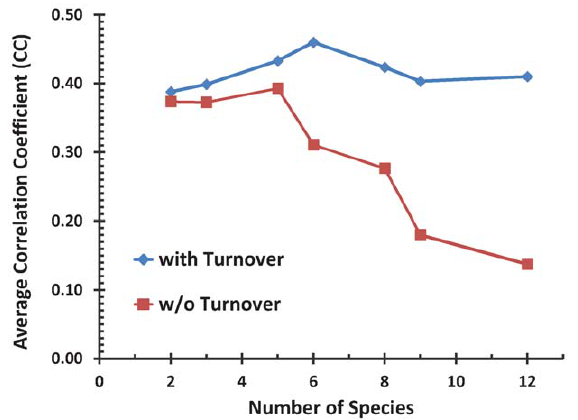
Figure 5. Effect of evolutionary filter on binding sites used in model. The average CC over all 37 CRMs of the DirectInt model (without cooperative DNA-binding) is shown. The x-axis indicates the number of species in which conservation of a binding site was required for it to be included in the model’s input. The red curve corresponds to the case where the conservation filter does not allow turnover, i.e., the sites used in the model must be fully conserved across all species considered. The blue curve represents a conservation filter that allows turnover, i.e., where a site may undergo lineage-specific changes. Thus for ‘‘number of species’’=6, a site used in the model may be conserved in six or fewer species, as long as the conservation is deemed significant by the procedure described in Text